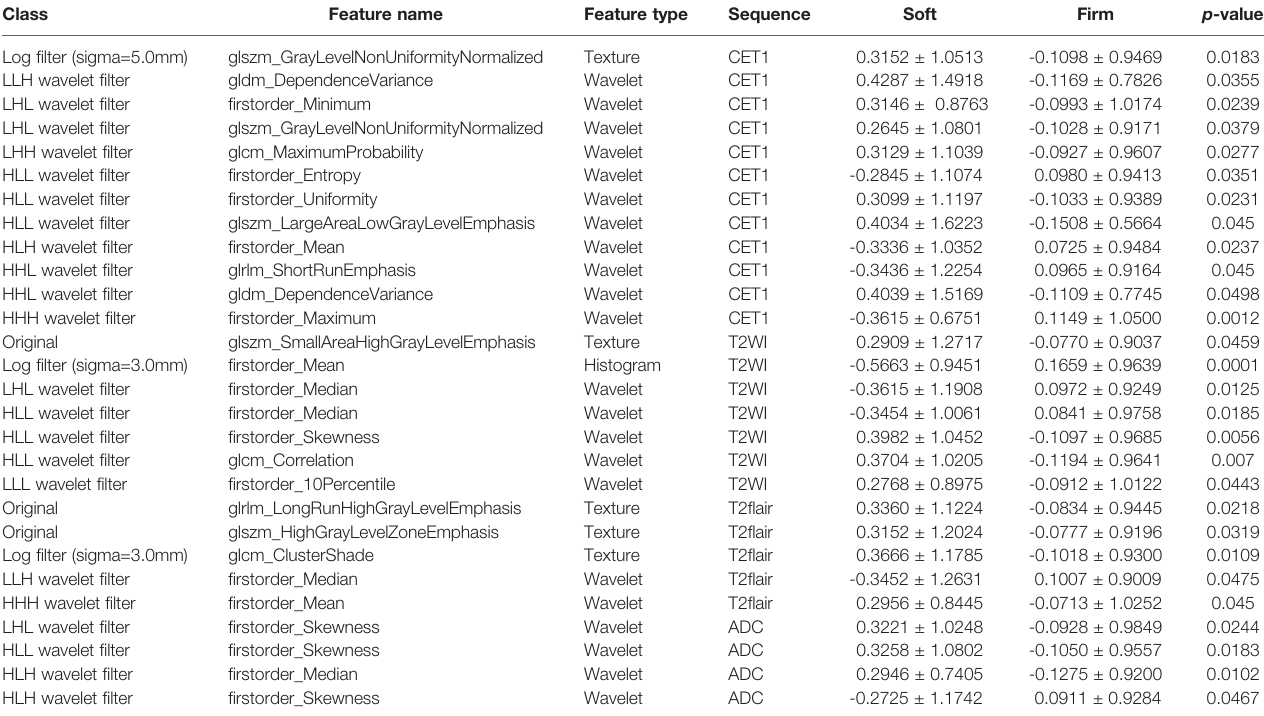
TABLE 2 | The details of selected radiomics features.